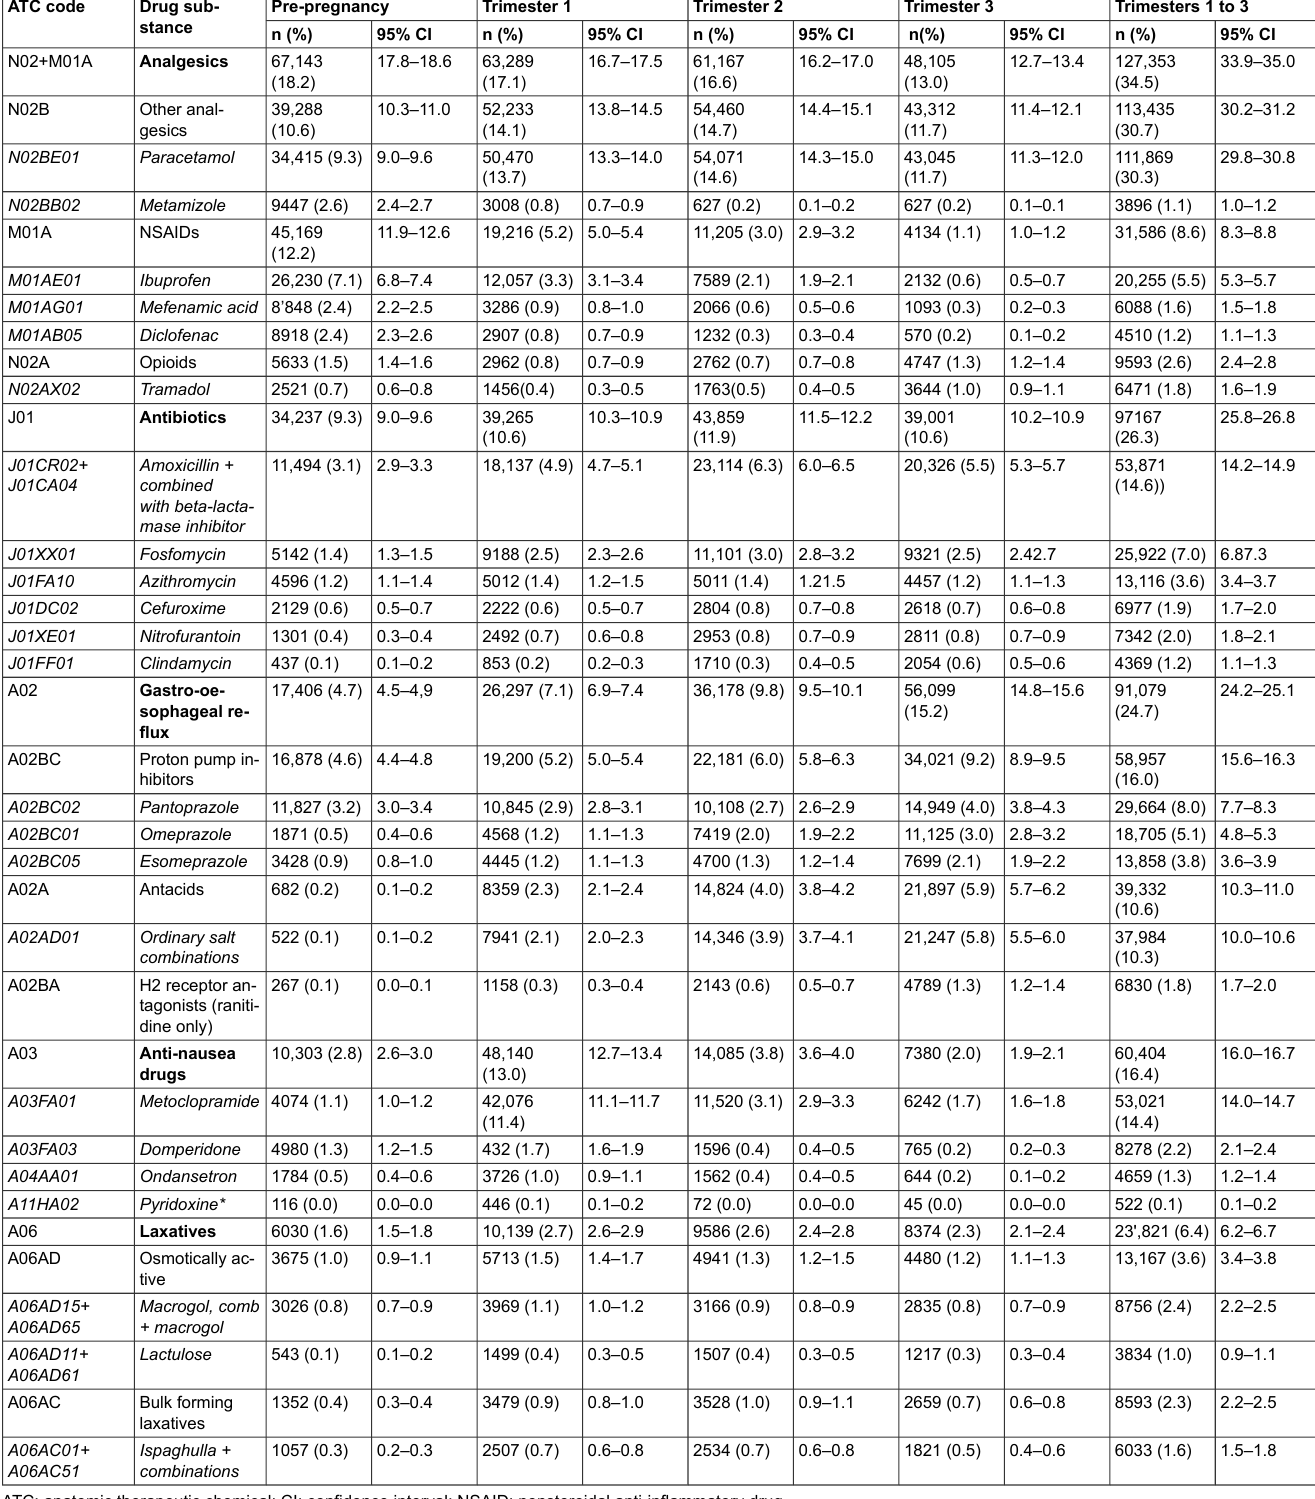
Table 3: Exposure prevalence to different drug groups and active substances during pregnancy overall and within trimester of pregnancy and pre-pregnancy separately (extrapolated numbers). ATC code Drug sub-